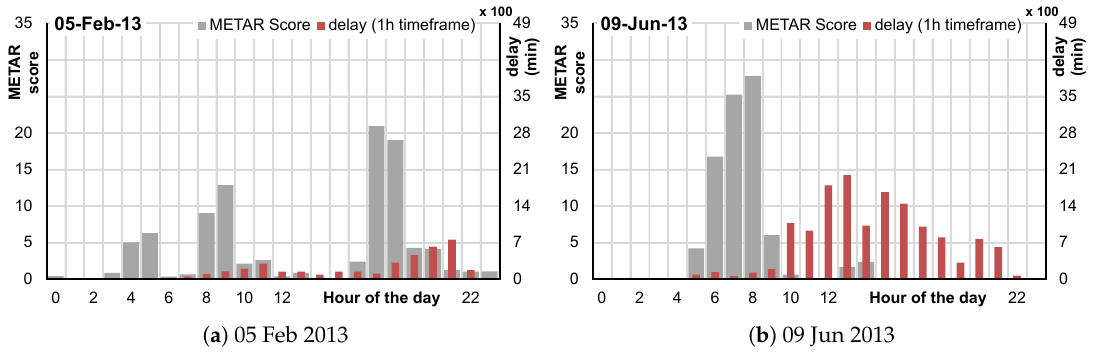
Figure 11. Weather/delay progress considering dangerous events.